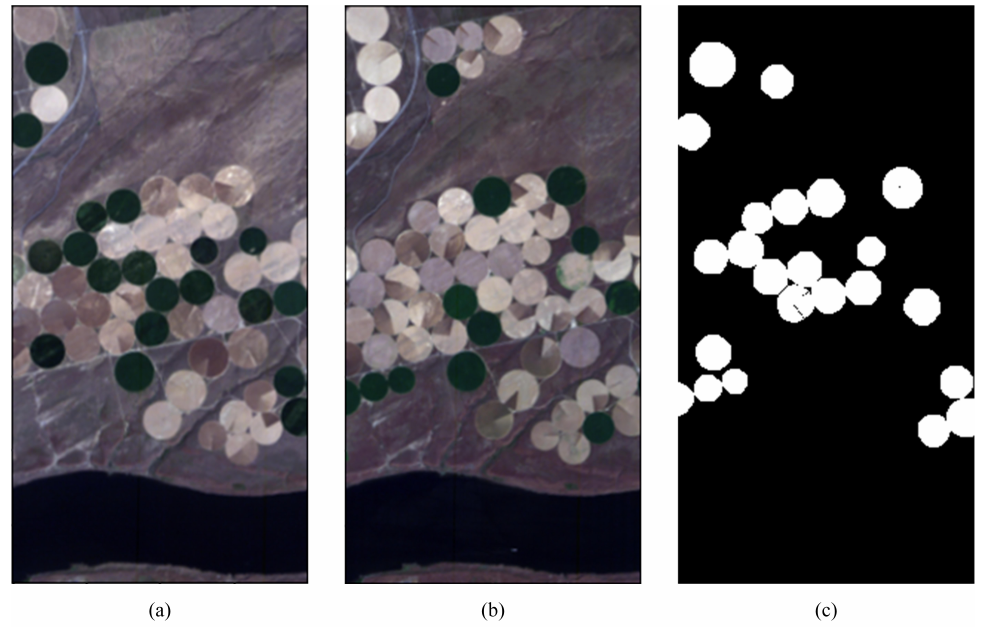
Figure 2. The Hermiston City area dataset. ( a ) Image acquired in 2004. ( b ) Image acquired in 2007. ( c ) Reference map.